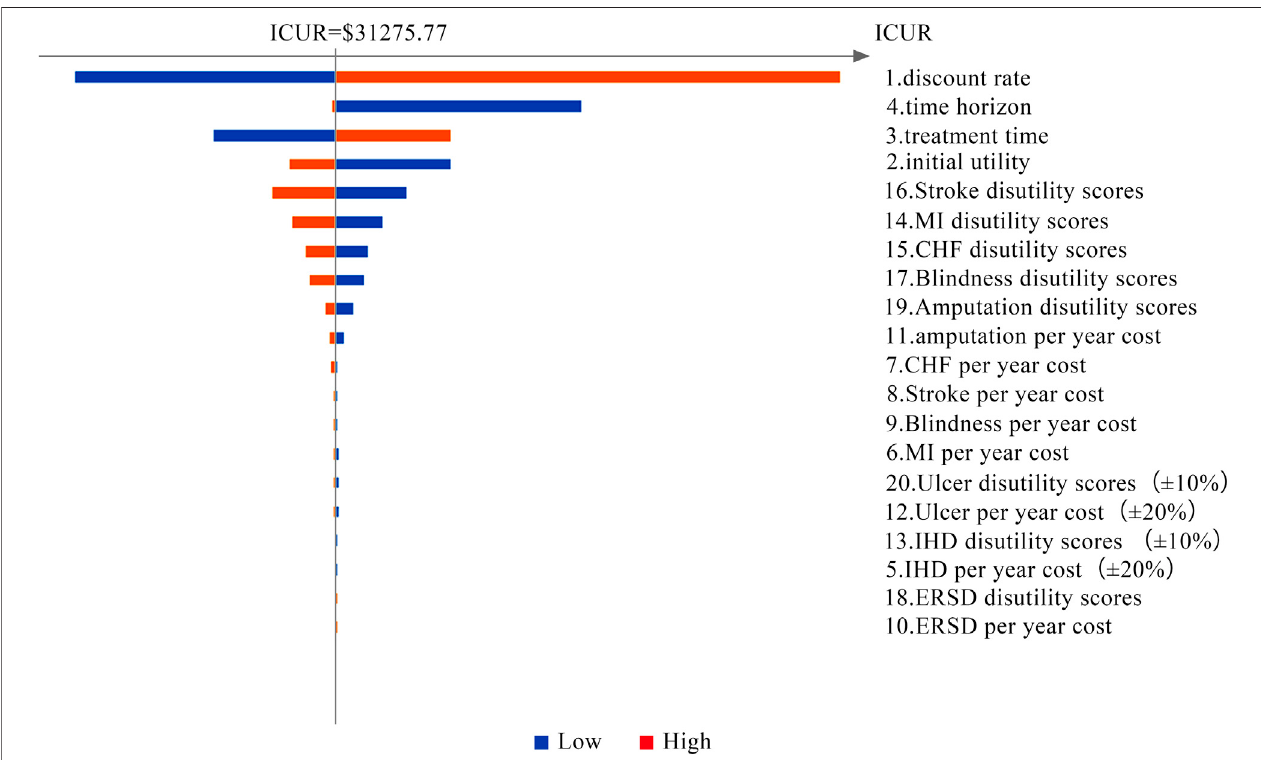
FIGURE 3 | Tornado diagram of the one-way SA (at C 3 λ (cid:2) $1,007.18).